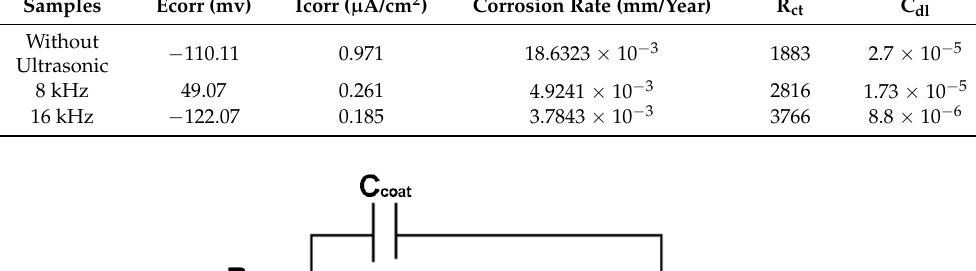
Figure 6. Bode Plots: ( a ) log |z| Vs log f and; ( b ) phase angle Vs log f for ultrasonic treated on TiN coatings at 8 kHz and 16 kHz for various holding times. Table 2. Corrosion parameters calculated from Tafel and electrochemical impedance spectroscopy (EIS) for ultrasonic treatment on TiN coating at 8kHz and 16 kHz for different holding times. Samples